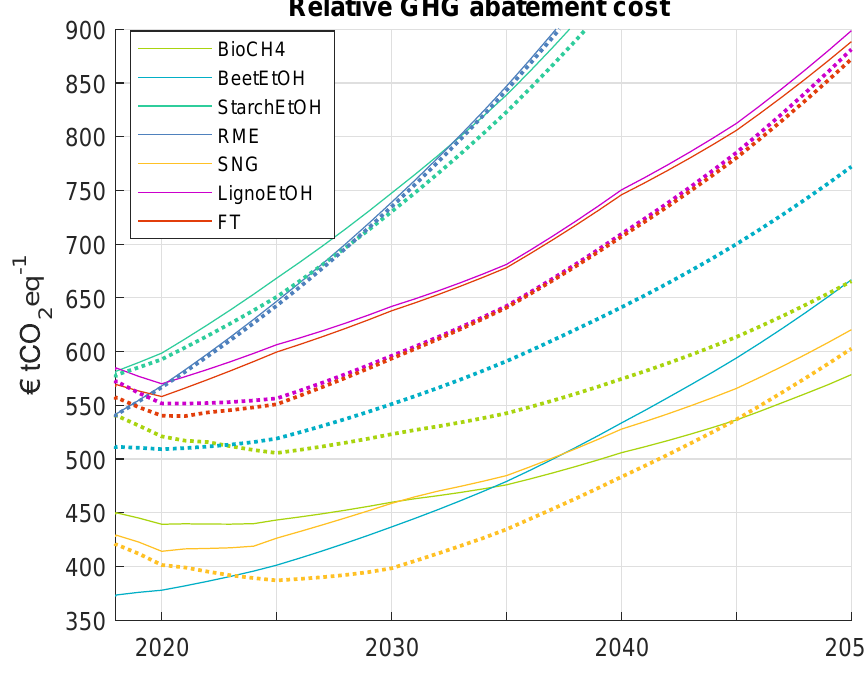
Figure 6. Biofuel relative GHG abatement cost developments ( € tCO 2 eq − 1 ) in scenarios (a, solid lines) and (c, dotted lines). Some developments are outside of the plot: the cost of RME increases to ca. 1300 € tCO 2 eq − 1 , and the cost of StarchEtOH increases to ca. 1230 € tCO 2 eq − 1 in both